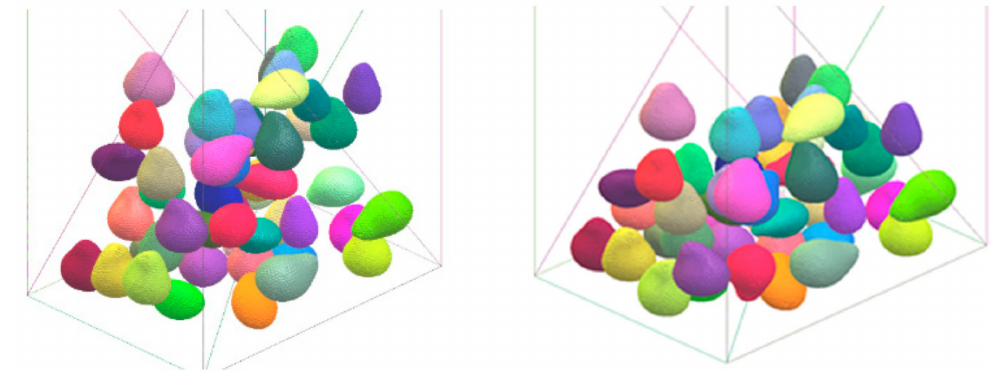
Figure 7. An example of geometries representing produce distribution in a box. Two snapshots showing how the random packing of shapes occurs in the discrete element modeling approach. Progress in the model occurs until the shapes can no longer “settle”, which means that no shape will move further under the influence of gravity alone [44].